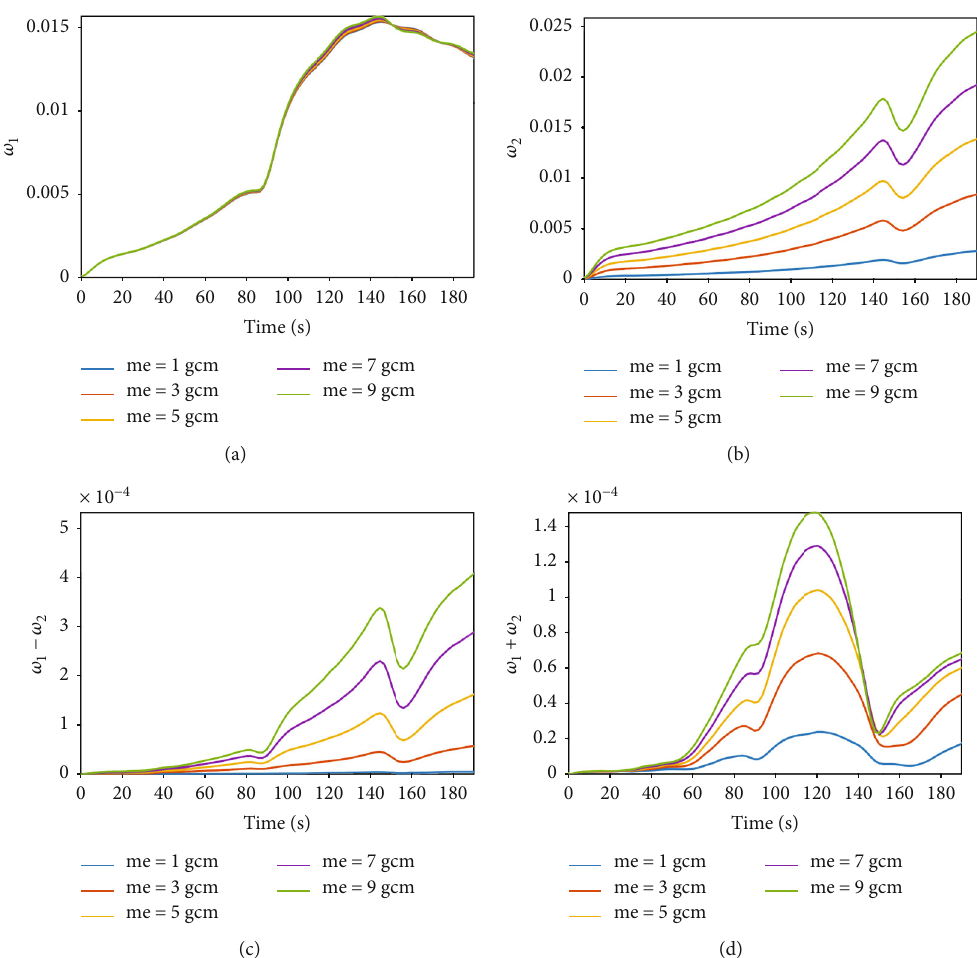
Figure 14: Responses at the analysis node of PT rotor with in fl uence of PT rotor unbalance: (a) ω